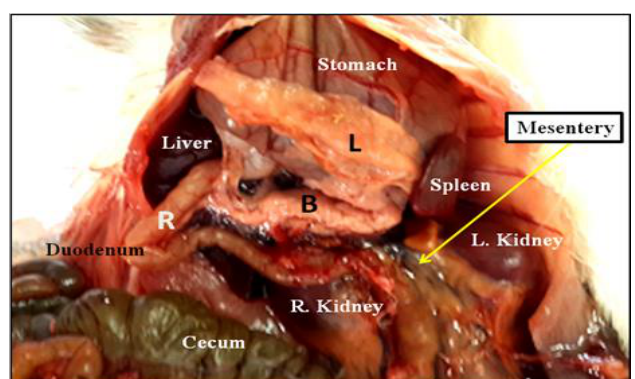
Figure 1. Mesentery hold and fixed right (R), body (B) and left (L) pancreatic lobes with the aid of the surrounding labeled organs.